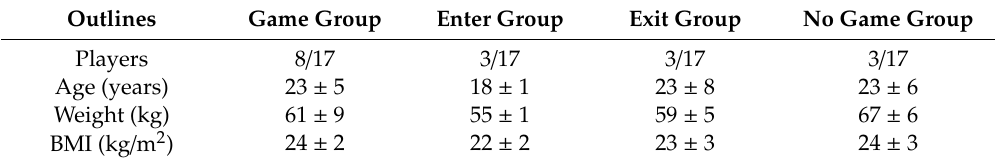
Table 1. Main characteristics of the female soccer players involved in the